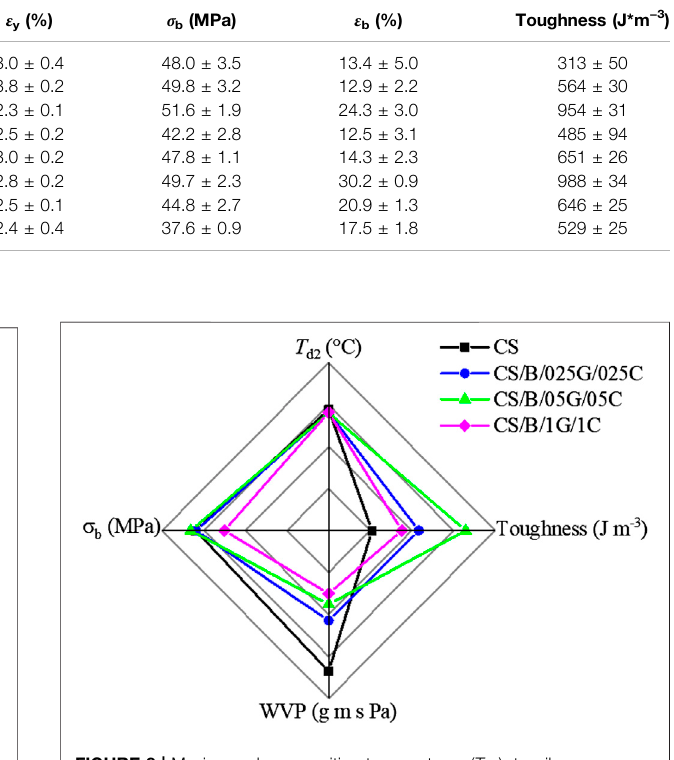
FIGURE 8 | Maximum decomposition temperatures ( T d2 ), tensile strength at break ( σ b ), toughness, and water vapor permeability values (WVP) of pristine CS and cross-linked CS-based hybrid nanocomposite fi